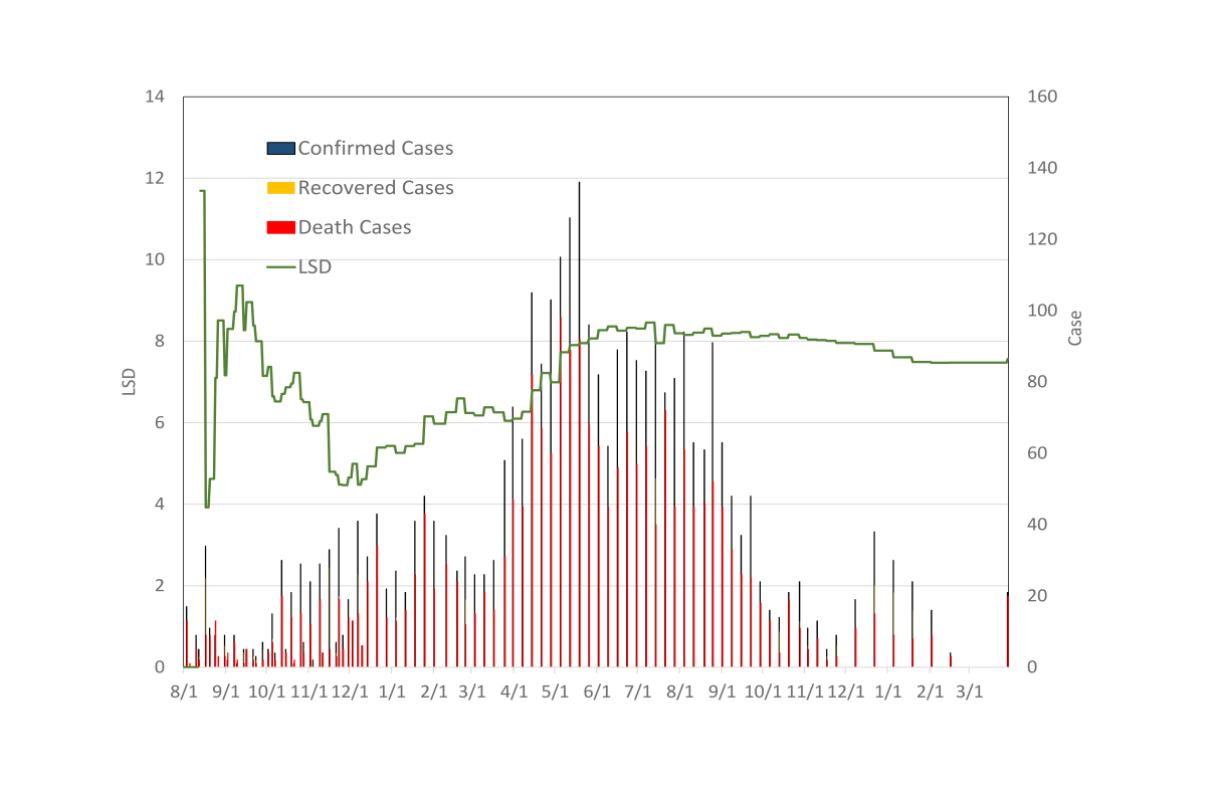
Figure 7. LSD index for the Ebola outbreak in the Democratic Republic of the Congo, 2018. The LSD index was estimated as 11.7 at the initial stage on August 12, 2018. The LSD index never became less than one. LSD: lifting social